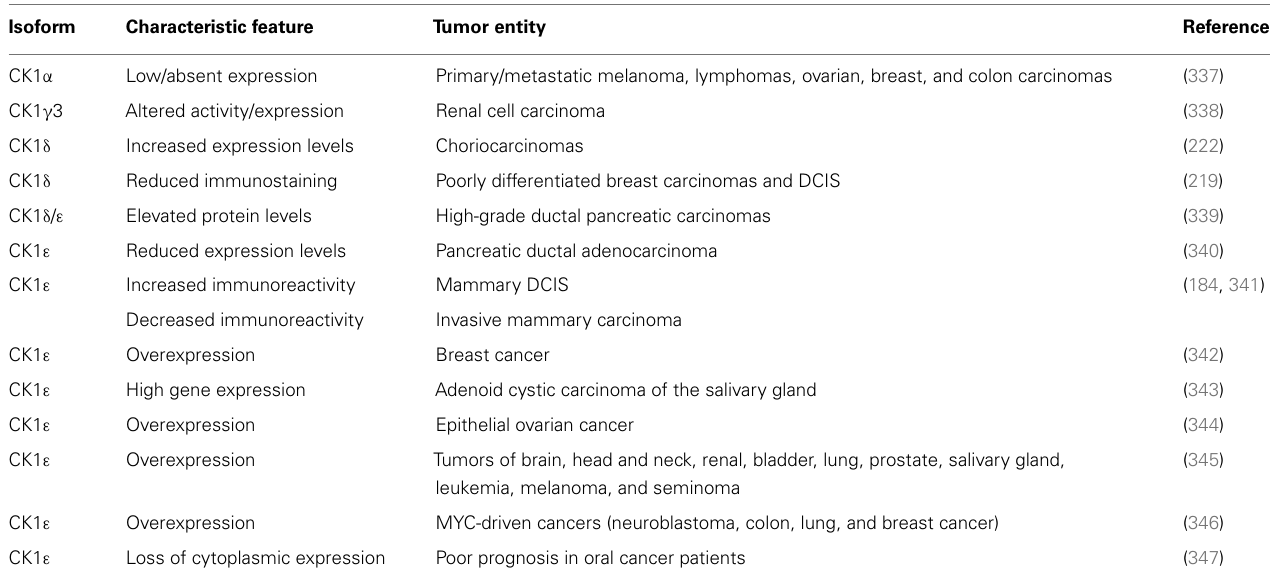
Table 2 | CK1 isoforms in different tumor entities